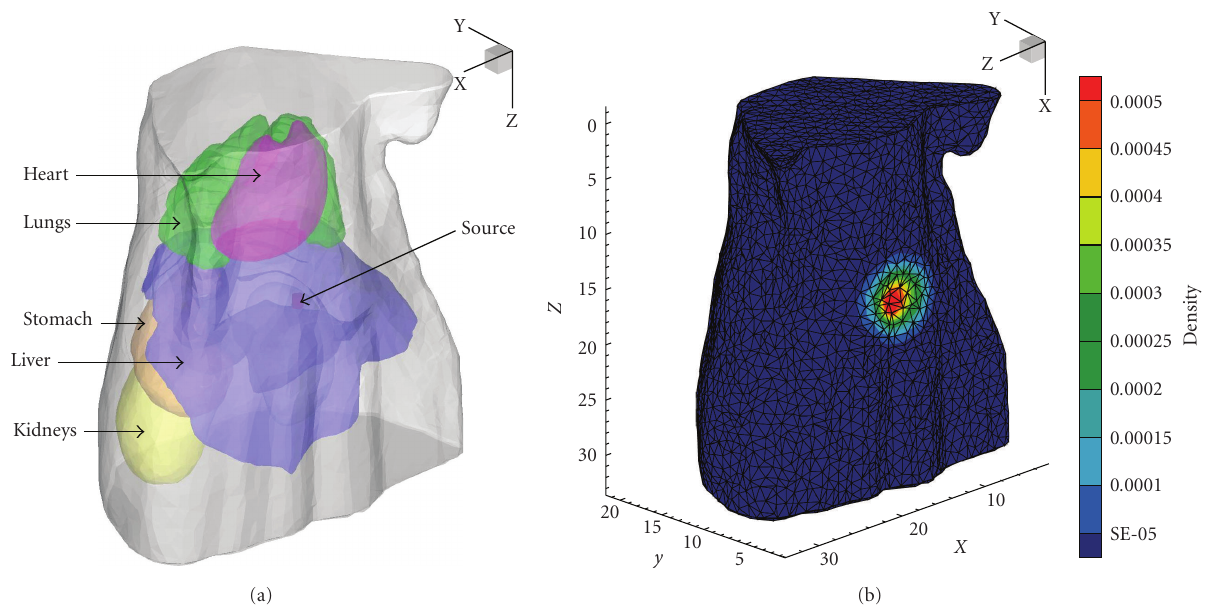
Figure 6: A 3D digital mouse model. (a) The torso of the mouse model with a cylindrical source in the liver. (b) Forward mesh and photon distribution on surface.